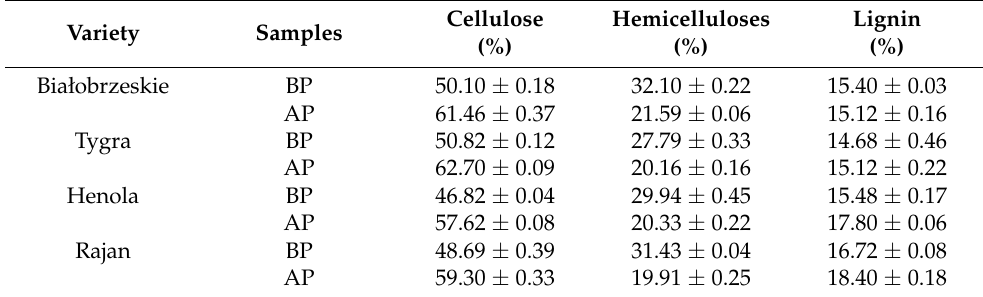
Table 3. The chemical composition of hemp biomass (percentage of dry matter); BP: before pretreat- ment; AP: after pretreatment.